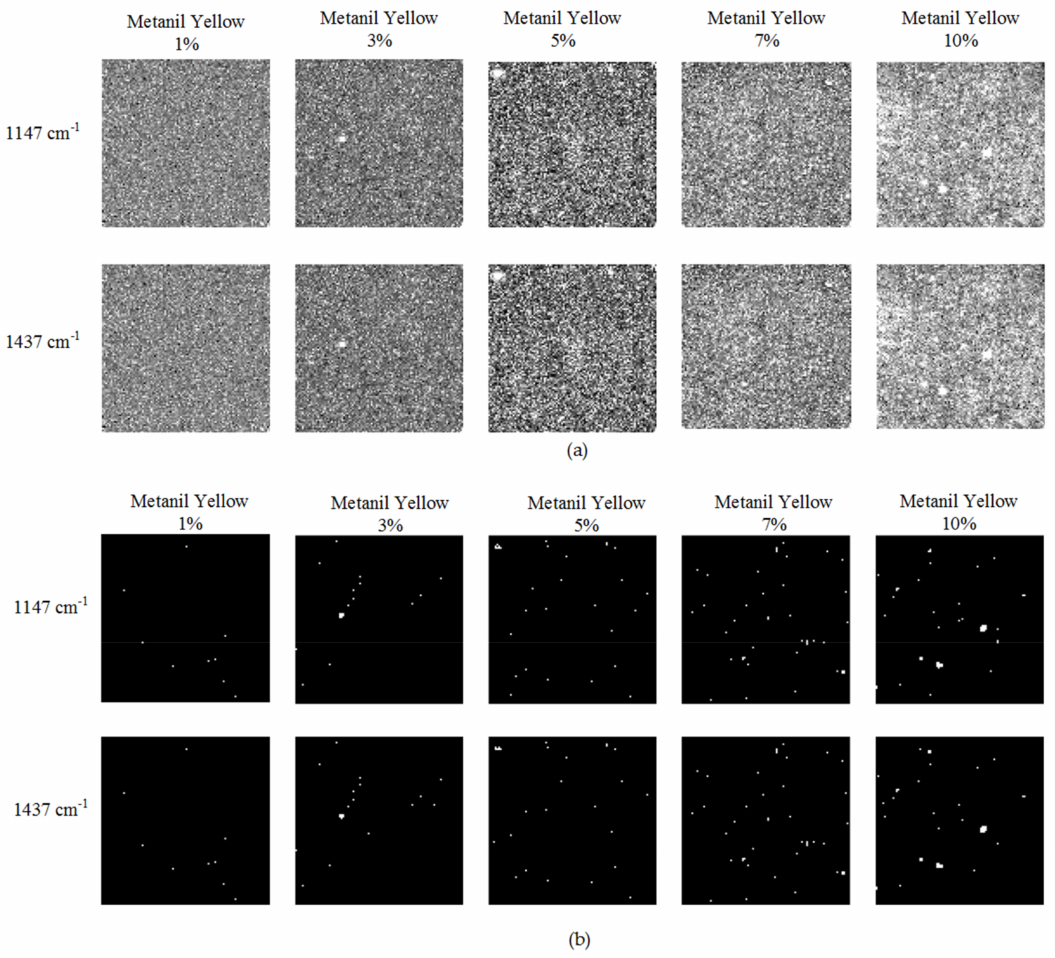
Figure 7. ( a ) Hyperspectral Raman images of curry powder–metanil yellow mixture samples; ( b ) binary detection images at 1147 cm − 1 and 1437 cm − 1